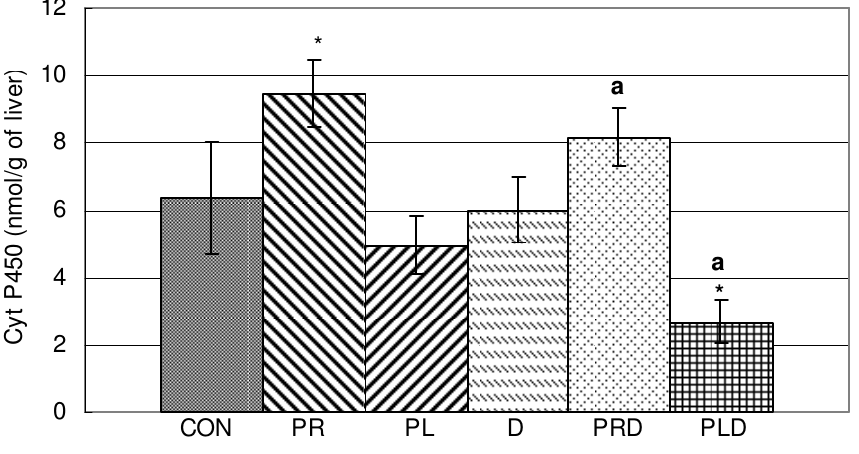
Figure 7. Effects of doxorubicin, parsley leaves and roots juices and their combination on Cyt P450 in liver homogenate. t-test, n =  6; compared to CON group: * p < 0.05, compared to D group: a p < 0.05.